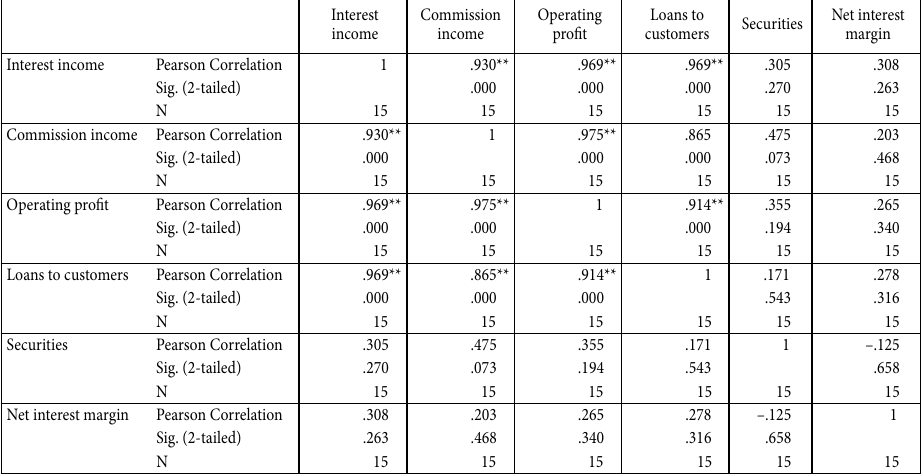
Fig. 2. Results of the correlation analysis for output